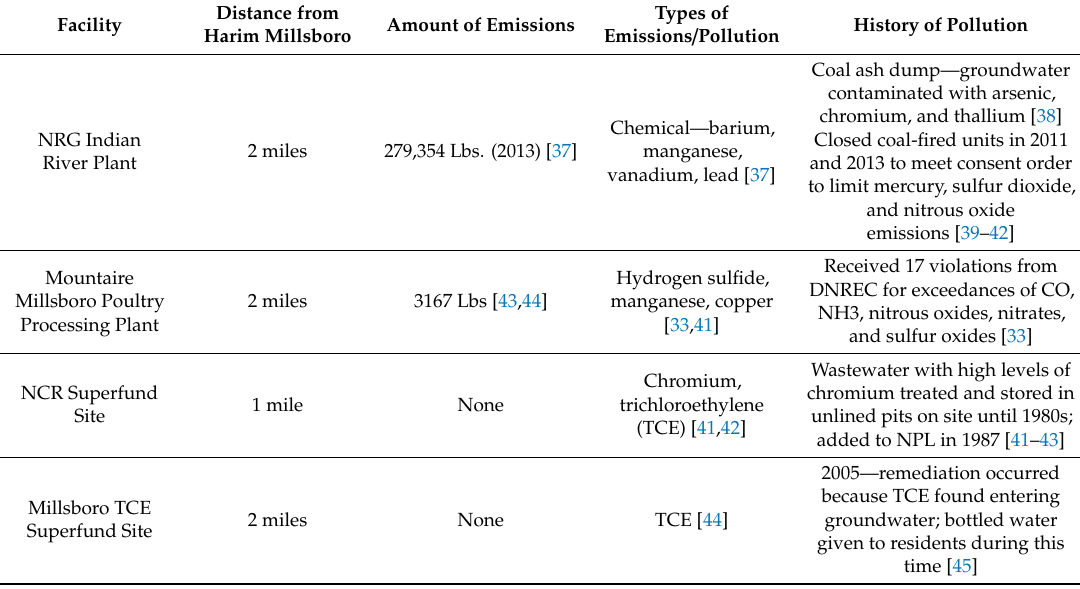
Table 1. Summary of Existing Hazards Near Millsboro.